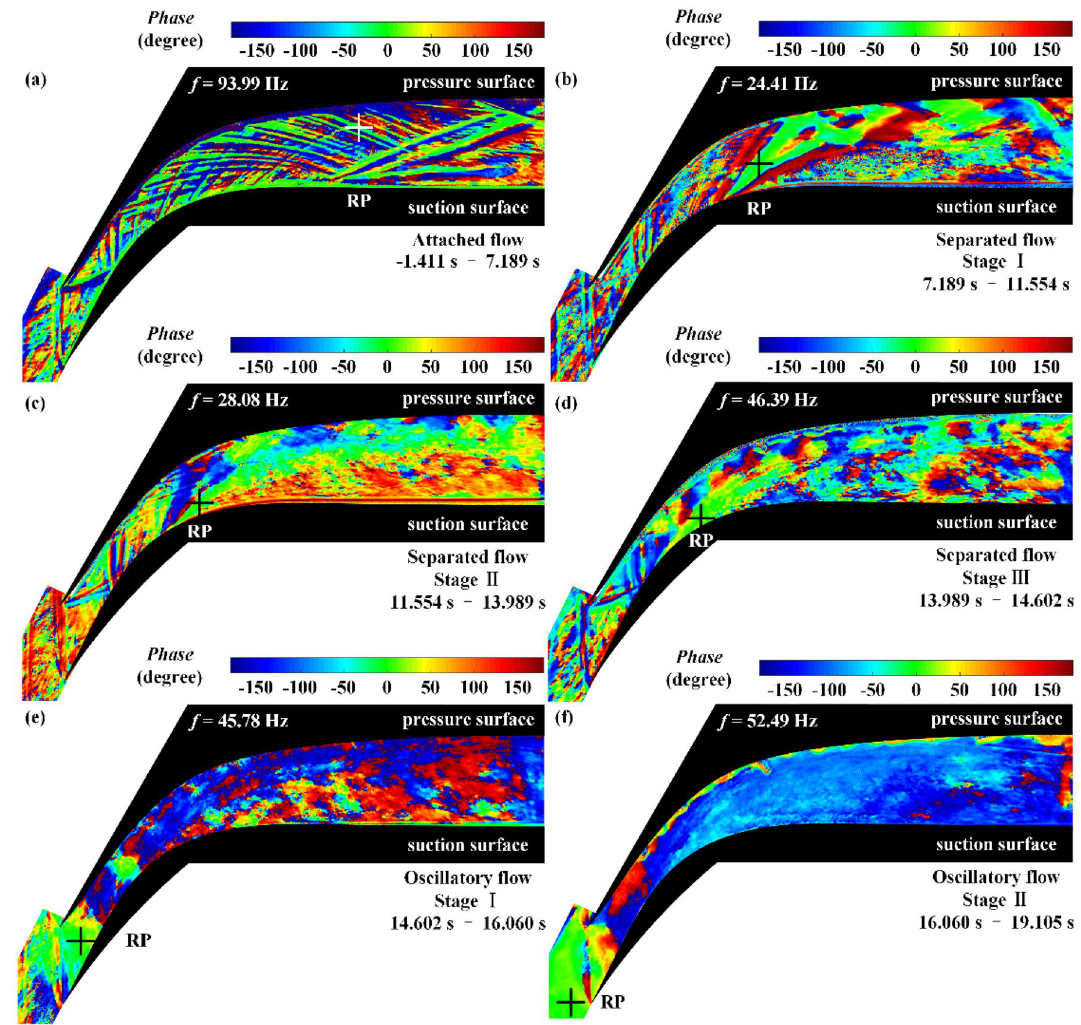
Figure 13. Phase contours of the flow field during ( a ) attached flow, ( b ) stage I of separated flow, ( c ) stage II of separated flow, ( d ) stage III of separated flow, ( e ) stage I of oscillatory flow, and ( f ) stage II of oscillatory flow. The symbol + represents the reference point